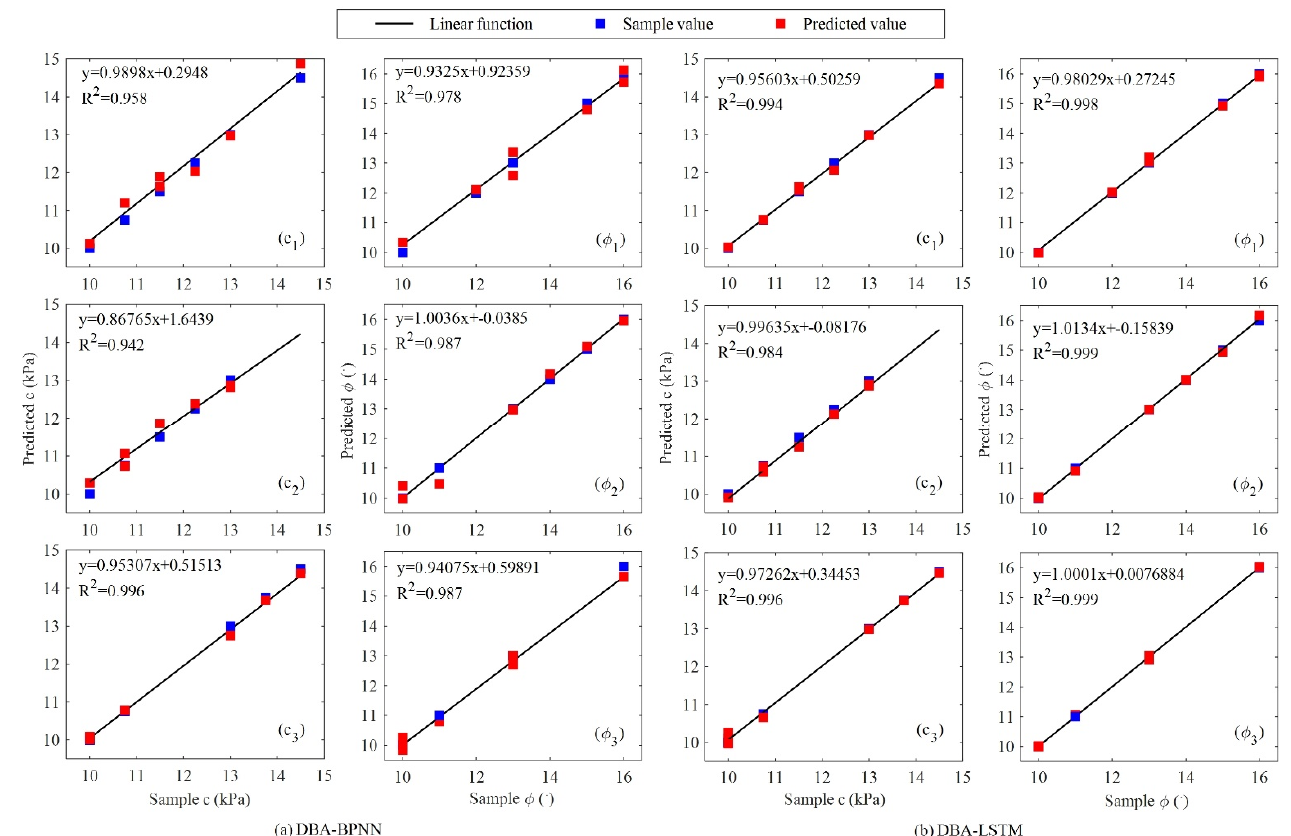
Figure 8. Fitting relationship and goodness of fit R 2 .